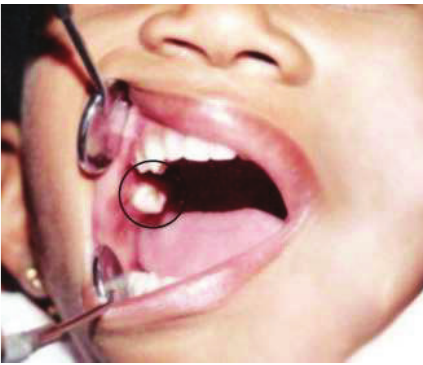
Figure 1: Intraoral view showing eruption of tooth-like mass from right buccal mucosa.